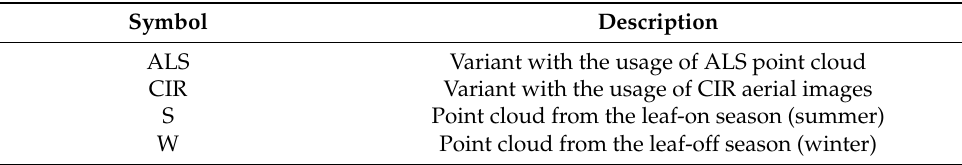
Table 4. Description of symbol designations of particular